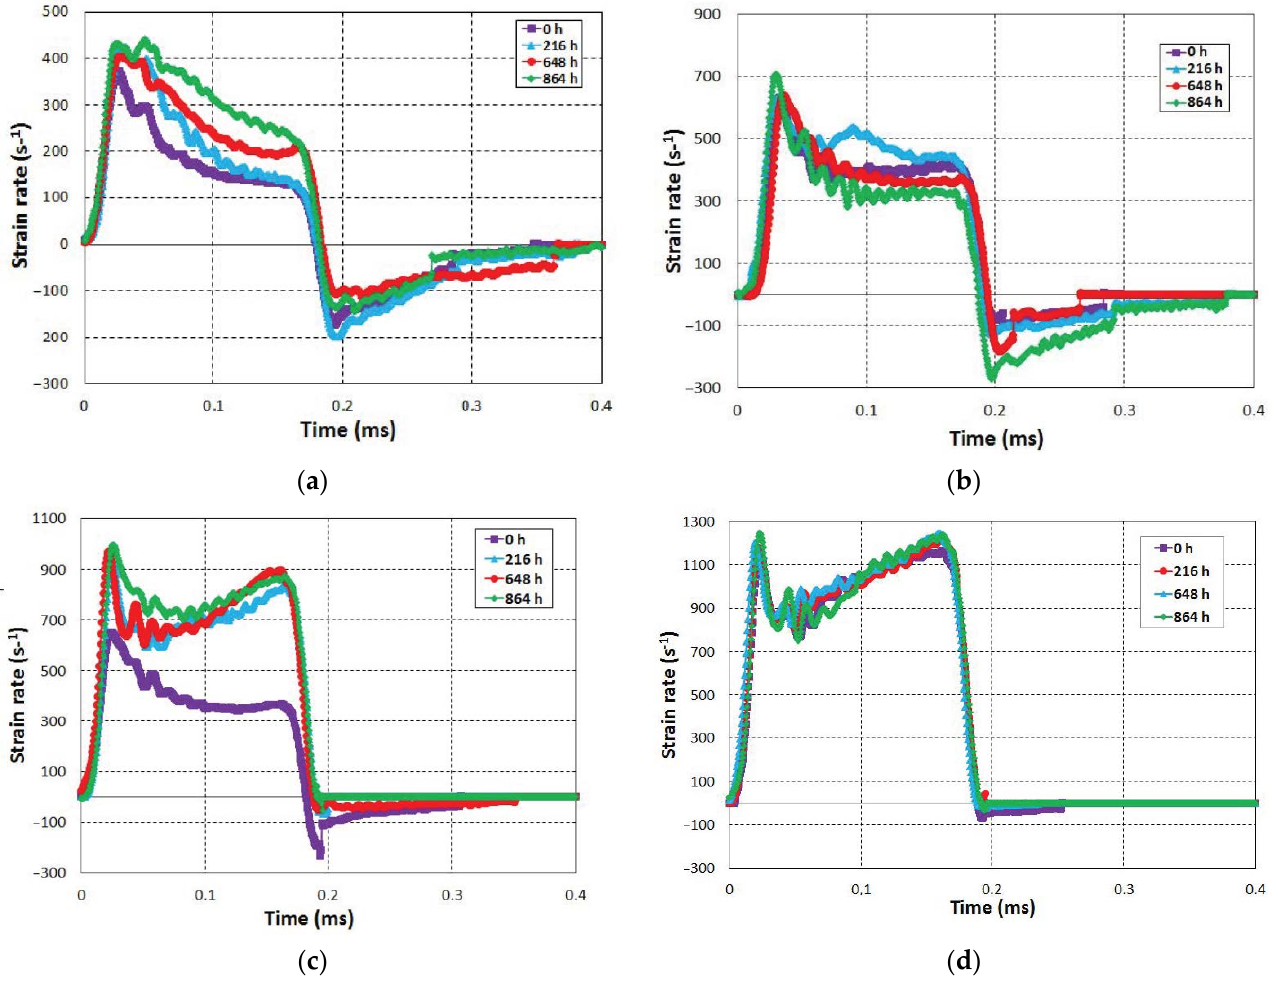
Figure 8. Strain rate versus time curves of the sample at different aging times and pressure under in-plane loading. ( a ) 1 bar. ( b ) 2 bar. ( c ) 3 bar. ( d ) 4 bar.